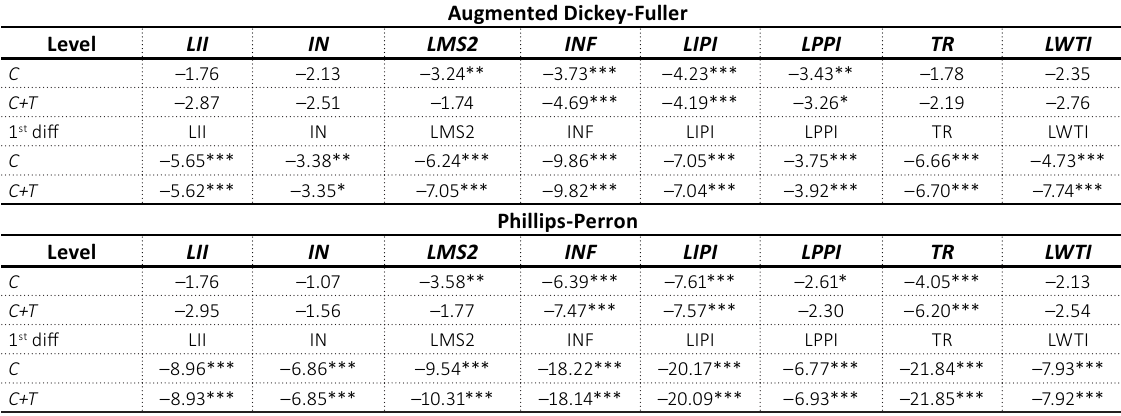
Table 3. Unit root